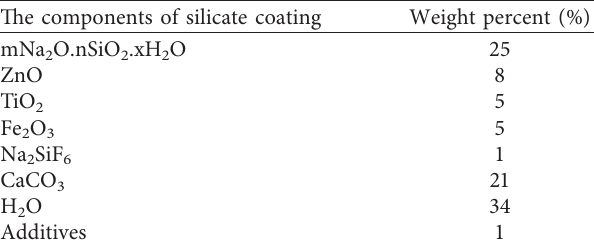
Scheme 1: Preparation of the silicate Table 2: The components of the silicate coating. The components of silicate coating